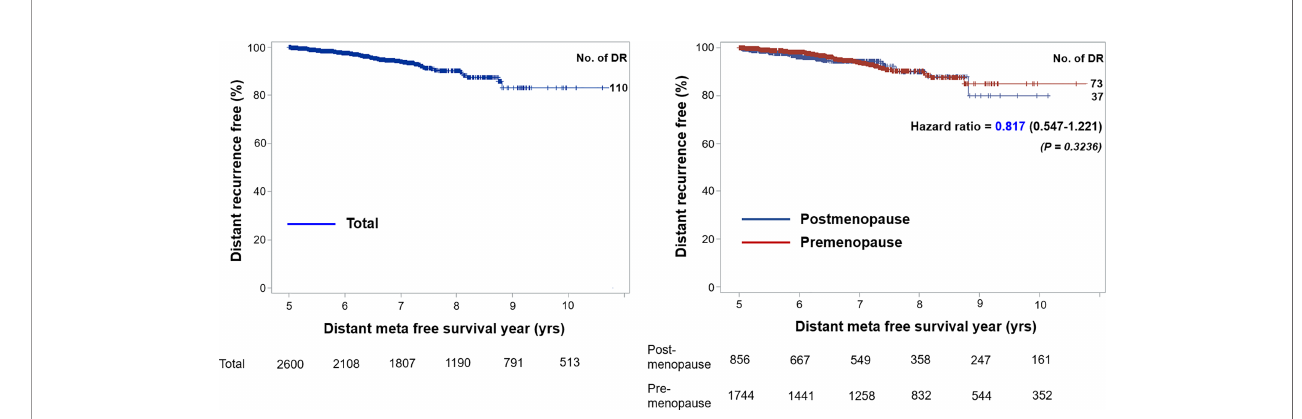
FIGURE 2 | Kaplan-Meier curves of distant recurrence-free